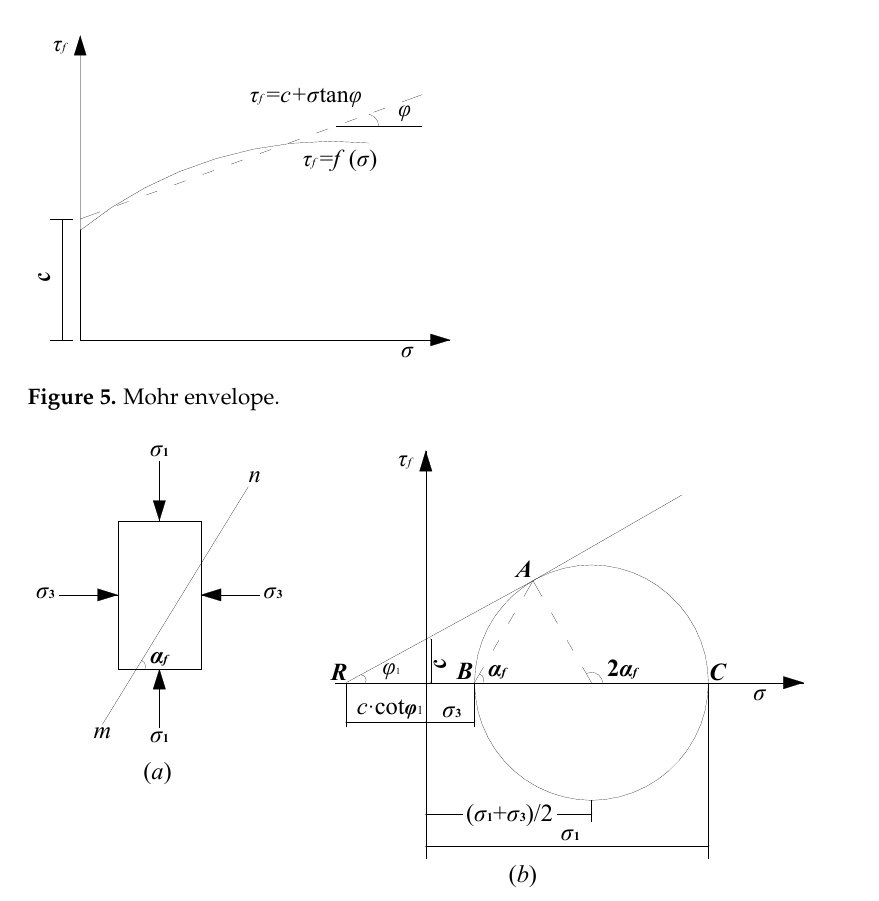
Figure 6. Mohr’s circle when any point of the material reaches equilibrium state ( a ) microelement, ( b ) Mohr’s circle.